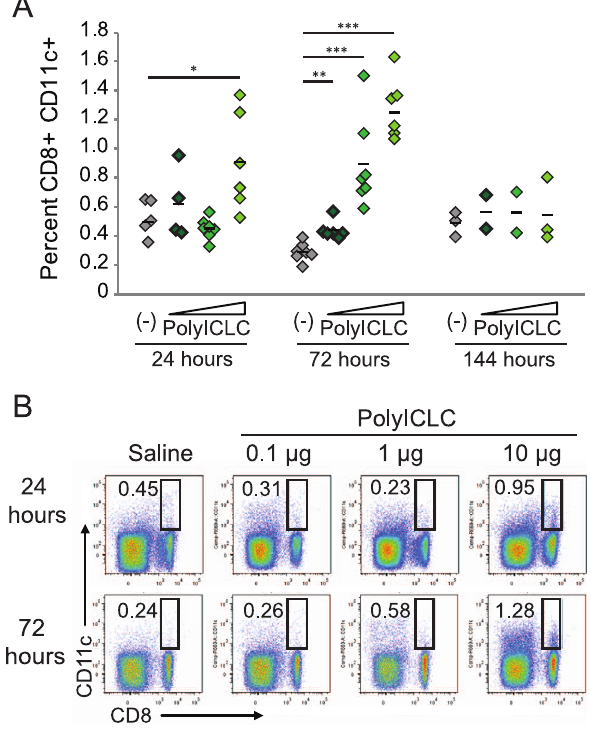
Figure 7. PolyICLC results in an increase of CD8 a + DC to the draining lymph node . (A) The percentage of CD8 a DC in the popliteal lymph node after vaccination, as described in Figure 6. (B) CD8 a DC percentages are the percentages of viable lymphocytes collected from the popliteal lymph node. Dot plots show CD11c on the y-axis and CD8 a on the x-axis with samples from animals treated with saline, 0.1, 1, or 10 m g of polyICLC (dose level indicated by triangle) 24 hours or 72 hours before sample collection. 200,000–500,000 events were collected in duplicate for each animal. P values were determined using the Student’s T-test by comparing the percentage of responding cells in animals vaccinated with VLP alone versus vaccination with VLP and various doses of polyICLC. ‘‘*’’ indicates p , 0.05, ‘‘**’’ indicates p , 0.005, and ‘‘***’’ indicates p , 0.0005. Four to five animals were utilized in each group for each iteration of this